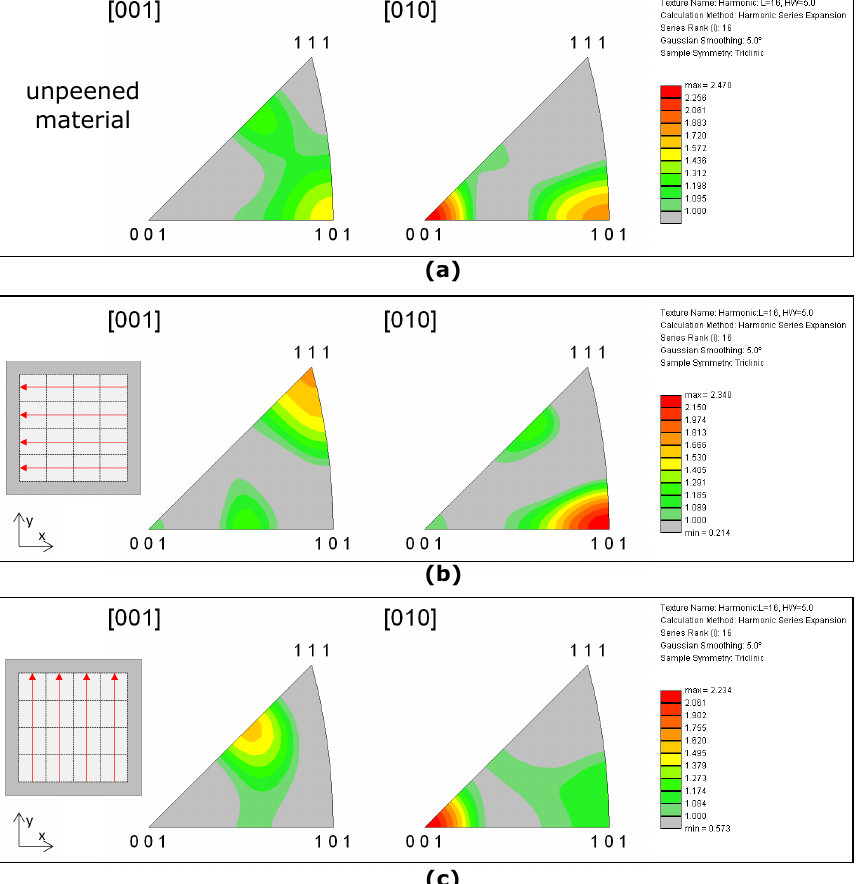
Figure 7. Inverse pole figures of unpeened and peened AA2024-T3clad specimens: The [001] direction is orthogonal to the rolling direction; the [010] direction corresponds to the specimens’ thickness direction: ( a ) unpeened material; one peening sequence was applied where the advancing direction was parallel to the rolling direction ( b ) or orthogonal to the rolling direction ( c